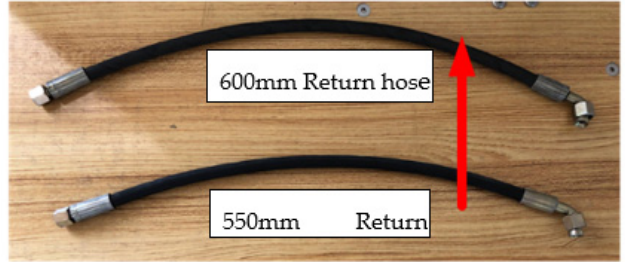
Figure 19. The hydraulic hose with different lengths.